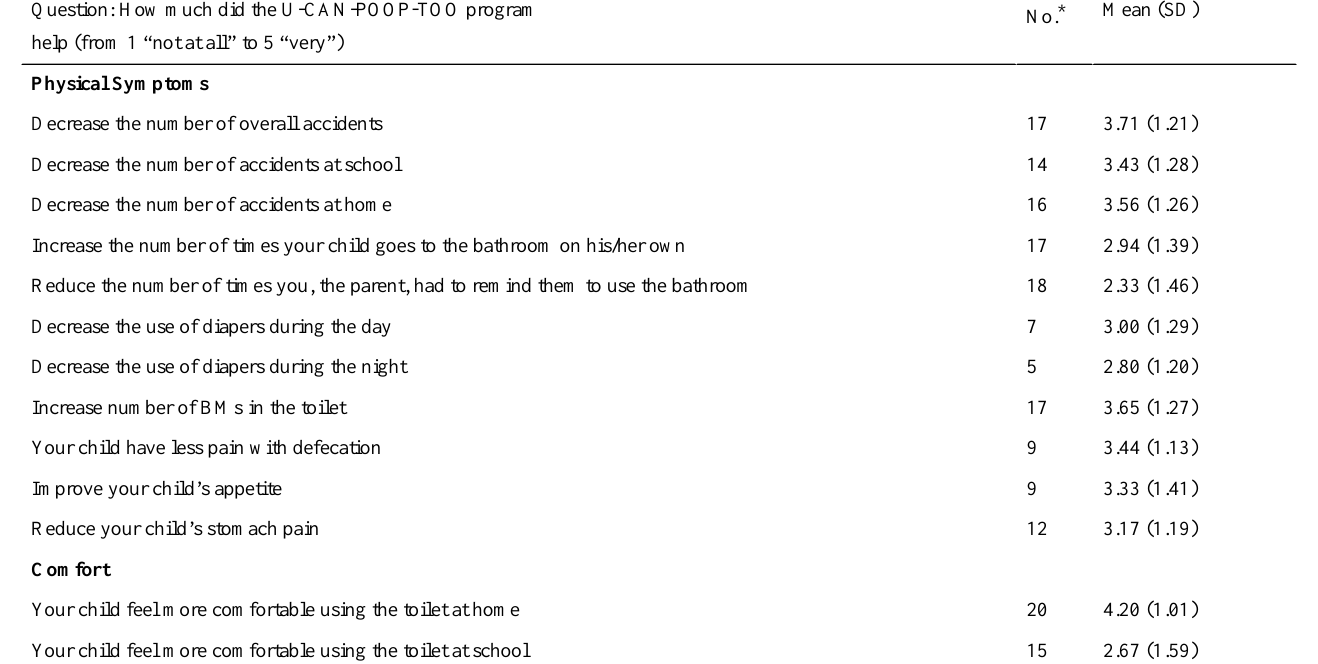
help (from 1 “not at all” to 5